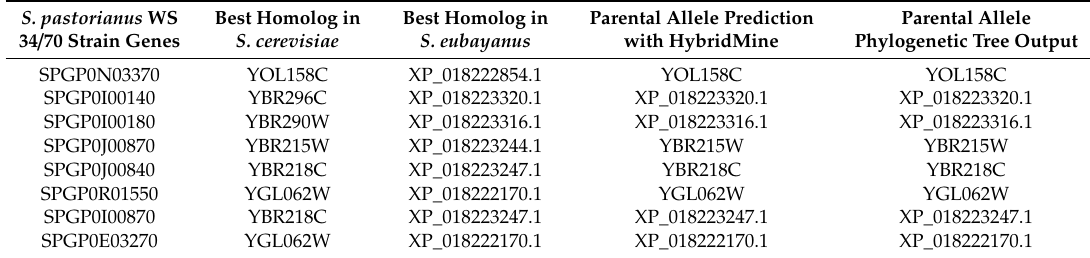
Table 3. HybridMine parental allele prediction output for eight S. pastorianus WS 34 / 70 genes and parental allele phylogenetic tree